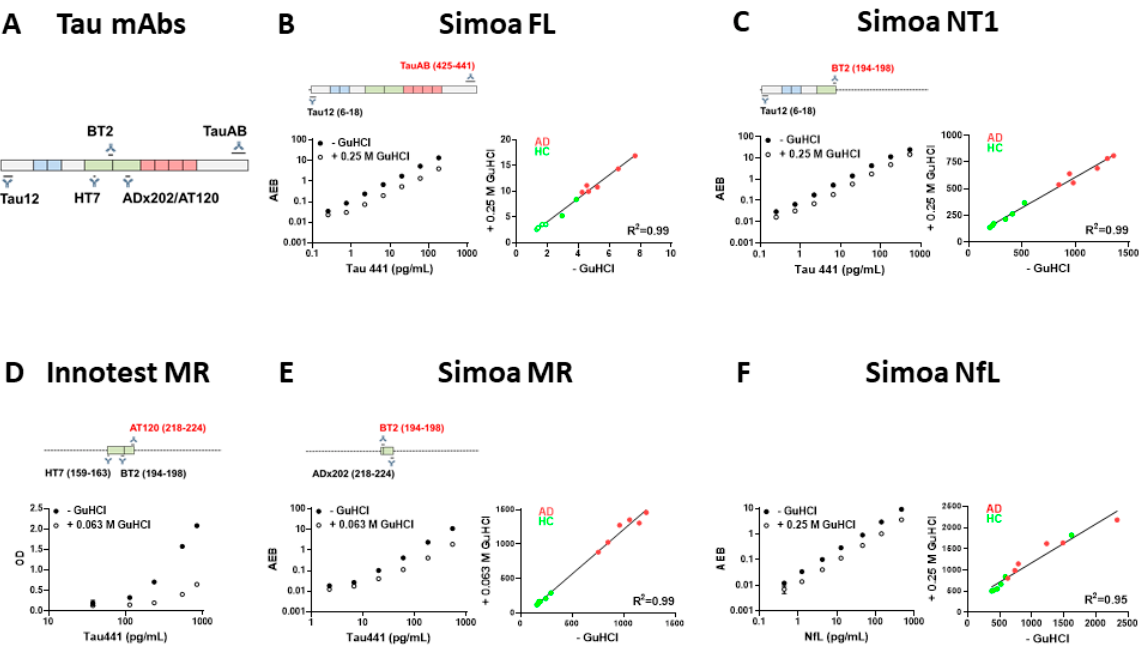
Figure 1. The sensitivity of the NfL, FL-tau, and NT1-tau assays are similar in the presence/absence of 0.25 M GuHCl. ( A ) Schematic representation of tau 441, and epitopes of antibodies used in each tau assay. Standard curves in the presence and absence of GuHCl for ( B ) Simoa FL-tau (LLoQ in the absence of GuHCl 0.25 pg/mL, LLoQ in the presence of 0.25 M GuHCl 0.74 pg/mL), ( C ) Simoa NT1-tau (LLoQ in the absence of GuHCl 0.25 pg/mL, LLoQ in the presence of 0.25 M GuHCl 0.74 pg/mL), ( D ) Innotest MR-tau ELISA (LLoQ in the absence of GuHCl 30 pg/mL, LLoQ in the presence of 0.063 M GuHCl 540 pg/mL), ( E ) Simoa MR (LLoQ in the absence of GuHCl 6.67 pg/mL, LLoQ in the presence of 0.063 M GuHCl 20 pg/mL), and ( F ) NfL (LLoQ in the absence of GuHCl 0.51 pg/mL, LLoQ in the presence of 0.25 M GuHCl 1.6 pg/mL). Each datapoint is the average ± SEM from a triplicate measurement. Where the error bars are not visible, the SEM is smaller than the size of the symbol. When appropriately diluted, GuHCl treatment did not alter detection of analytes in CSF specimens from 5 HC and 5 AD subjects (B, C, E and F right panels)-green circles are HC and red circles are AD patients (R 2 = 0.95–0.99). Open green circles indicate measurements below the LLoQ. Note: the dramatic reduction in sensitivity of the MR Innotest caused by GuHCl precluded measurement of tau in CSF.